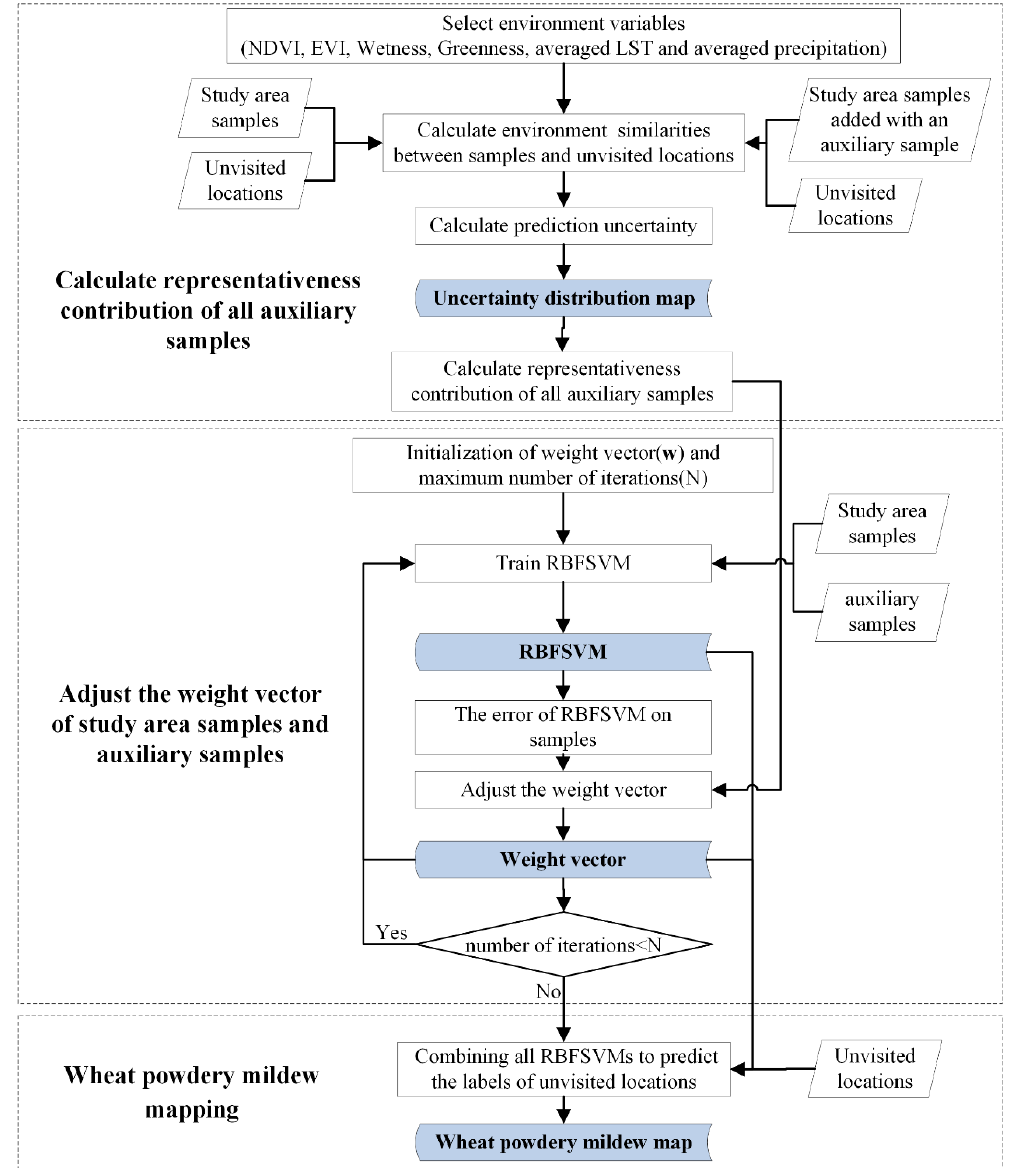
Figure 3. The flowchart of OpTrAdaBoost. RBFSVM: support vector machine with radial basis function kernel.